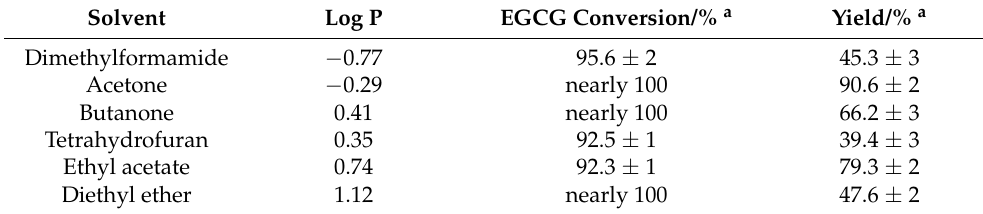
Table 4. Effect of solvent on the acylation